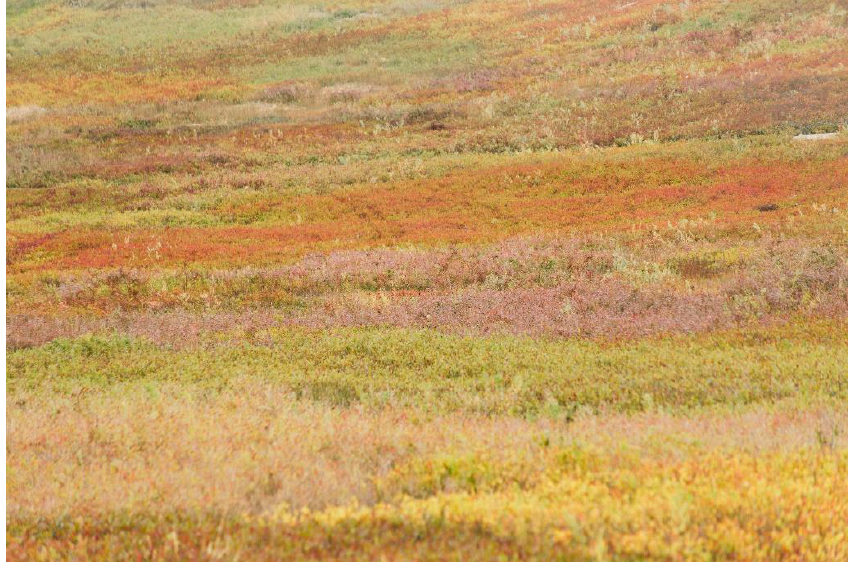
Figure 2. Different genotypes of wild blueberry plants ( Vaccinium angustifolium ) indicated by different leaf colors in a wild blueberry field at the Blueberry Hill Farm in Jonesboro, ME, USA.